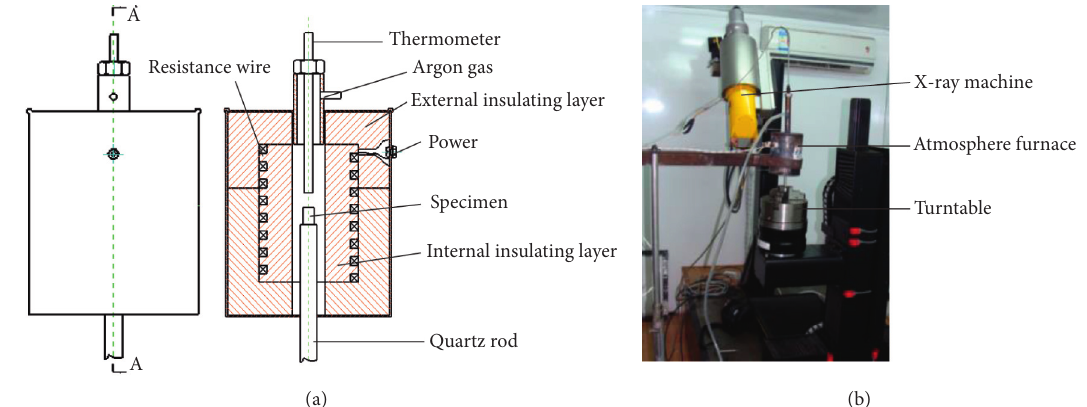
Figure 2: Experimental equipment. (a) Structure diagram of atmosphere furnace and (b) location of the CT machine and atmosphere furnace when